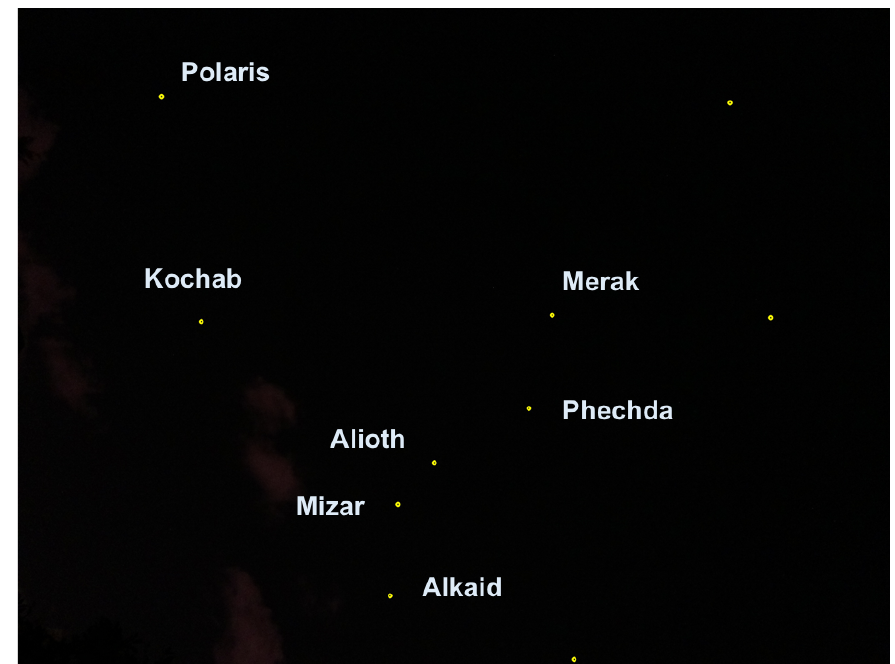
Figure 19. Star detection frame taken with a Raspberry Pi standard camera: Sony IMX-219, auto-exposure of 1 second and IS0